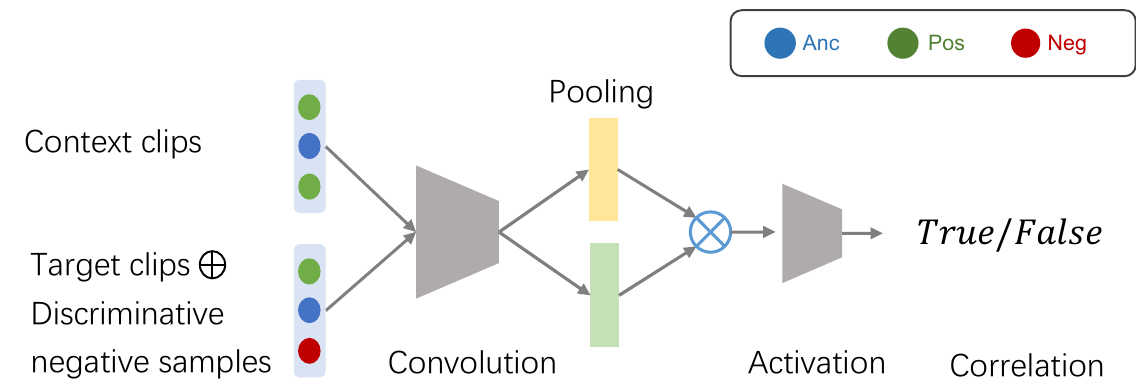
Figure 4. The frameworks of our continuous video semantic embedding methods. We utilized the continuous bag-of-video- words methods to encode context information into the embedding. Our methods try to model the correlation between the input pairs. It takes features of the context clips and the target clip as input, and we also provided hard negative samples by a well-designed discriminative negative sampling approach to ensure that the learned embedding not only encodes semantic coherence but also the discriminative degree of video